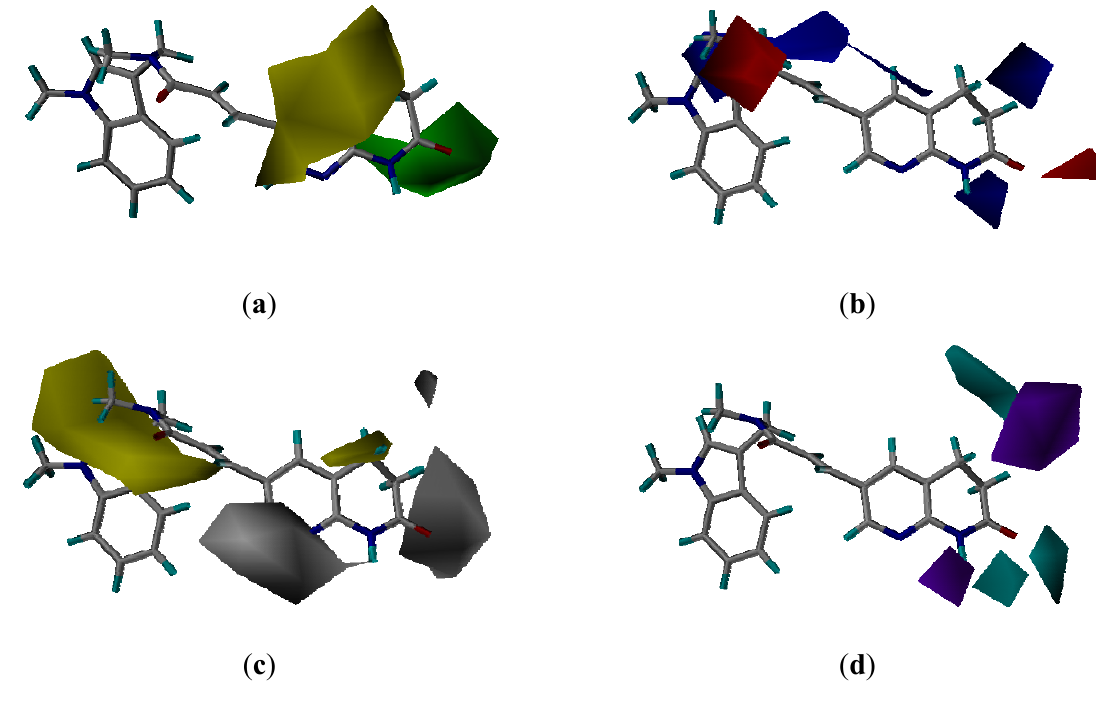
Figure 6. CoMSIA contour maps from docking-based alignment. ( a ) CoMSIA steric and electrostatic contour map. Green and yellow represent sterically favored and disfavored regions, respectively. ( b ) CoMSIA electrostatic contour map. Blue and red represent electrically favored and disfavored regions, respectively. ( c ) CoMSIA hydrophobic field contour map. Yellow regions indicate where hydrophobic groups increased activity and white regions indicate areas where hydrophilic groups increased activity. ( d ) CoMSIA H-bond donor contour map. Cyan contour indicates regions where hydrogen bond donor groups increased activity. Purple is disfavored. Compound 20 is shown inside the